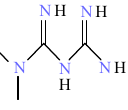
Figure 3: The chemical structure of